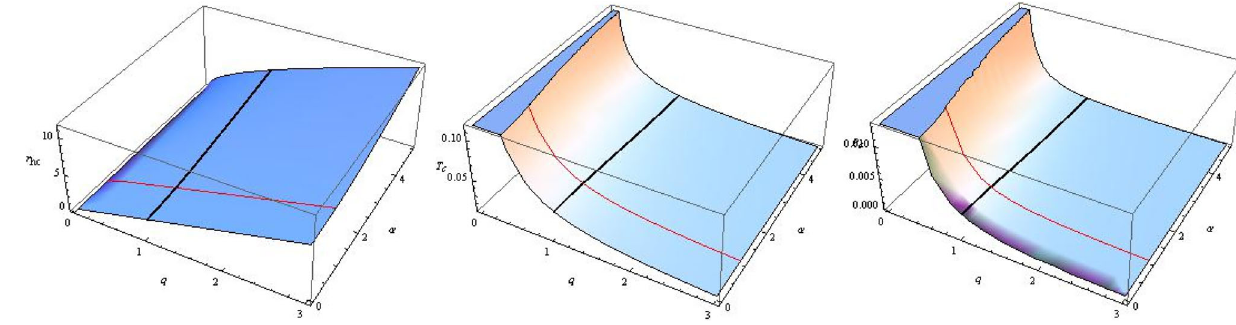
Fig. 1 The dependence of critical points on the parameters